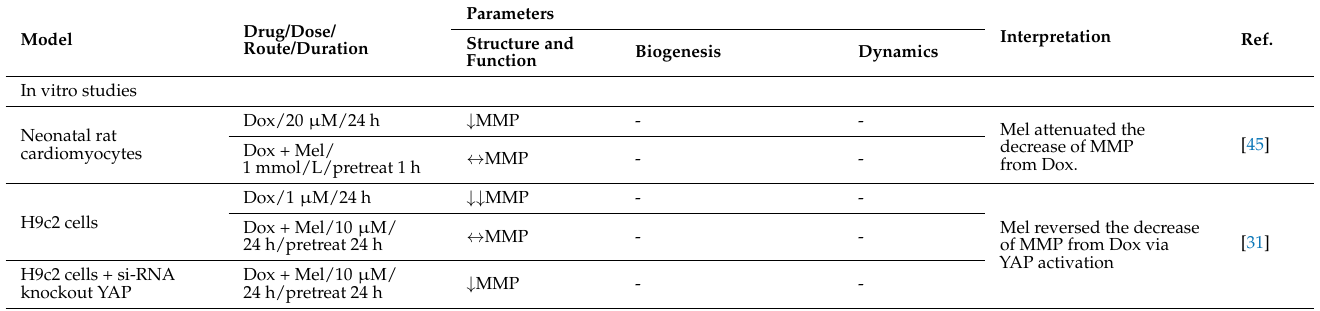
Table 2. Effects of melatonin on mitochondrial structure, function, biogenesis, and dynamics